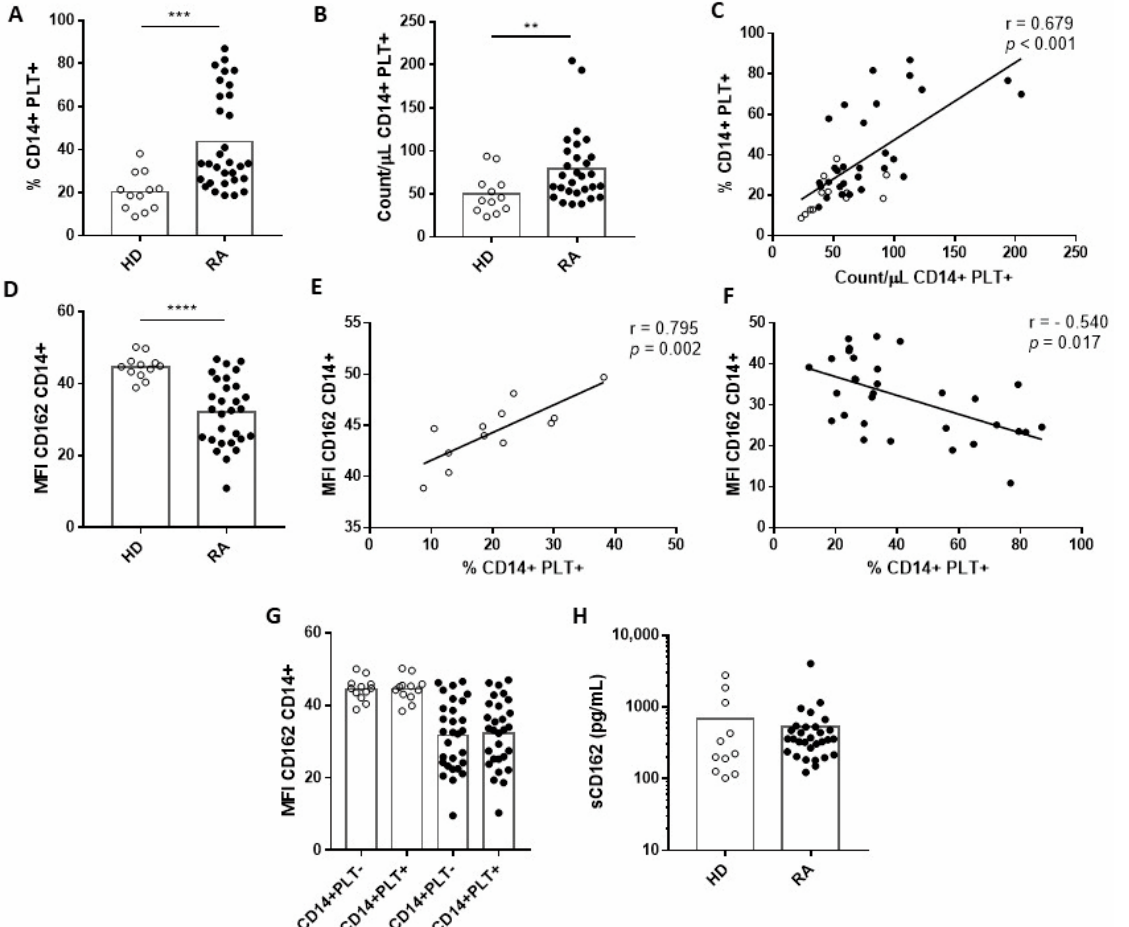
Figure 1. Monocytes with bound platelets and CD162 expression on monocytes from healthy donors (HD) and rheumatoid arthritis (RA) patients. ( A ) Percentage and ( B ) absolute numbers of monocytes with bound platelets (CD14+PLT+) in HD and RA patients. ( C ) Correlation between percentage and absolute number of CD14+PLT+ in HD and RA patients. ( D ) CD162 expression on monocytes from HD and RA patients. ( E ) Correlation between CD162 expression and percentage of CD14+PLT+ in HD and ( F ) RA patients. ( G ) CD162 expression on CD14+PLT- or CD14+PLT+ in HD and RA patients. ( H ) Quantification of soluble CD162 (sCD162) in plasma from HD and RA patients. White circles represent HD, and black circles represent RA patients. Statistical analysis was performed using the Mann–Whitney test for comparisons between HD and RA and Spearman’s correlation for correlation analysis. ** p < 0.01, *** p < 0.001, **** p <